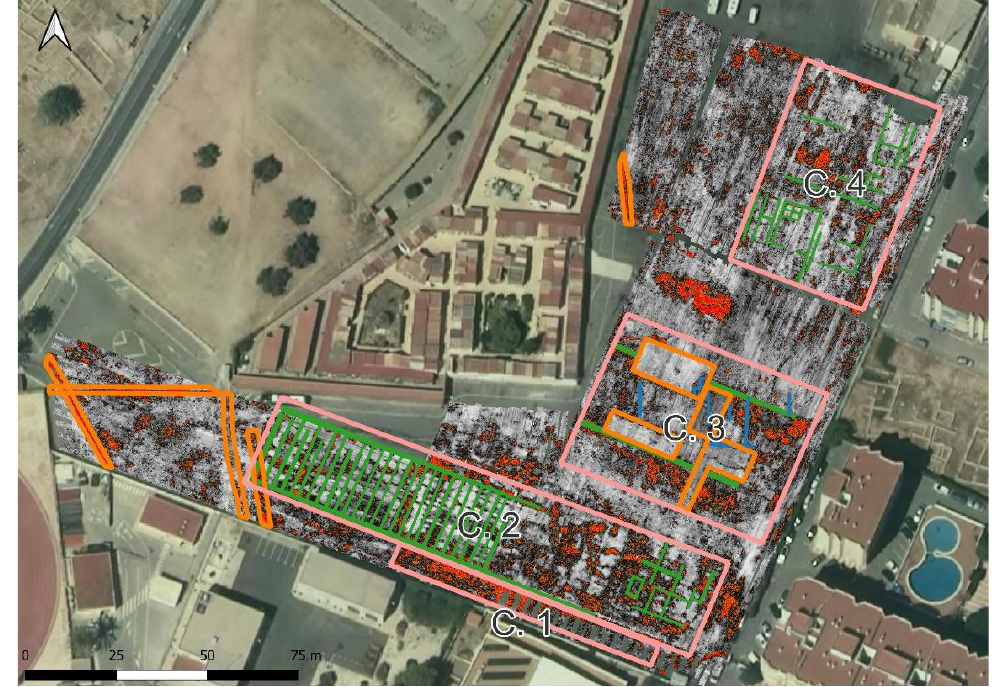
Figure 4. Four main sets detected (pink), together with readings related to documented recent alterations—recent excavations, canalisations, power lines, etc. (orange).